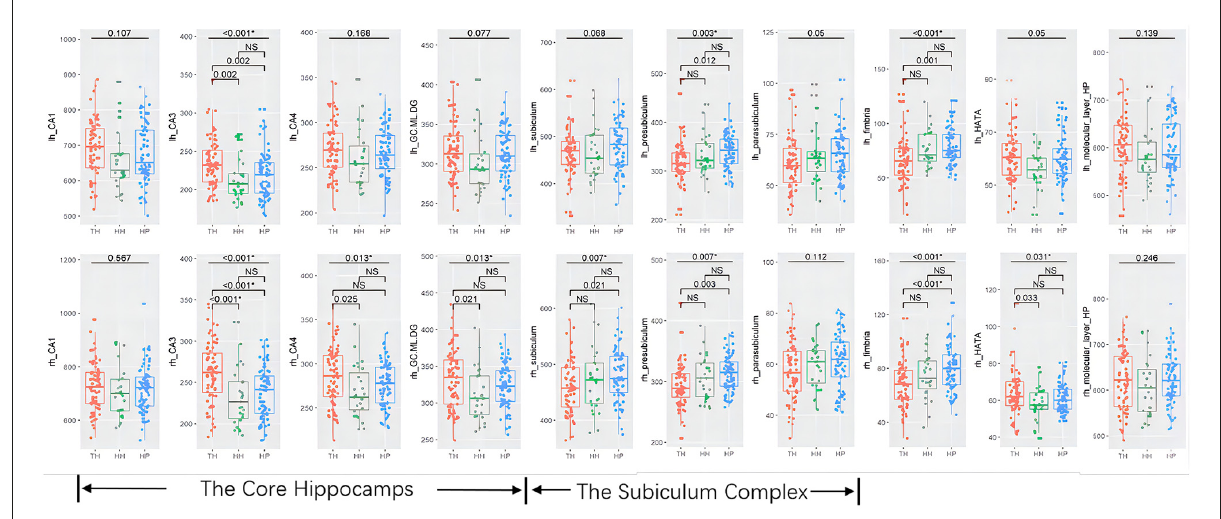
FIGURE3 Box-plots of subfields of the hippocampus in healthy Tibetan individuals living at high altitude (TH, adapted population, shown in red), Han Chinese individuals living at high altitude (HH, acclimatized newcomers, shown in green), and Han Chinese individuals living on the plain (HP, sea-level reference, shown in blue). The annotations show the FDR-corrected p values, and ∗ indicates statistical significance. lh, left hemisphere; rh, right hemisphere. NS, not